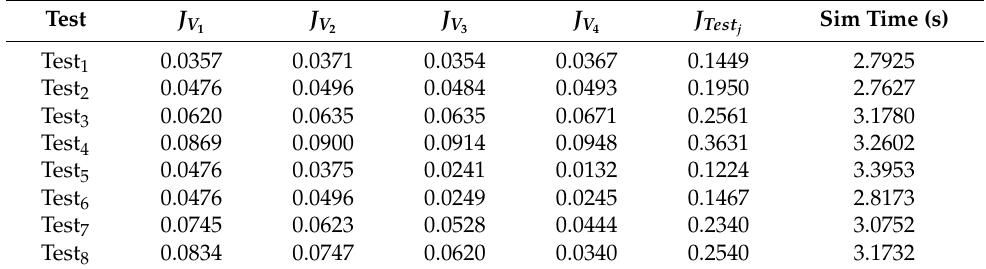
Table 2. Performance indices. All the numerical values are multiplied with 1.0 × 10 3